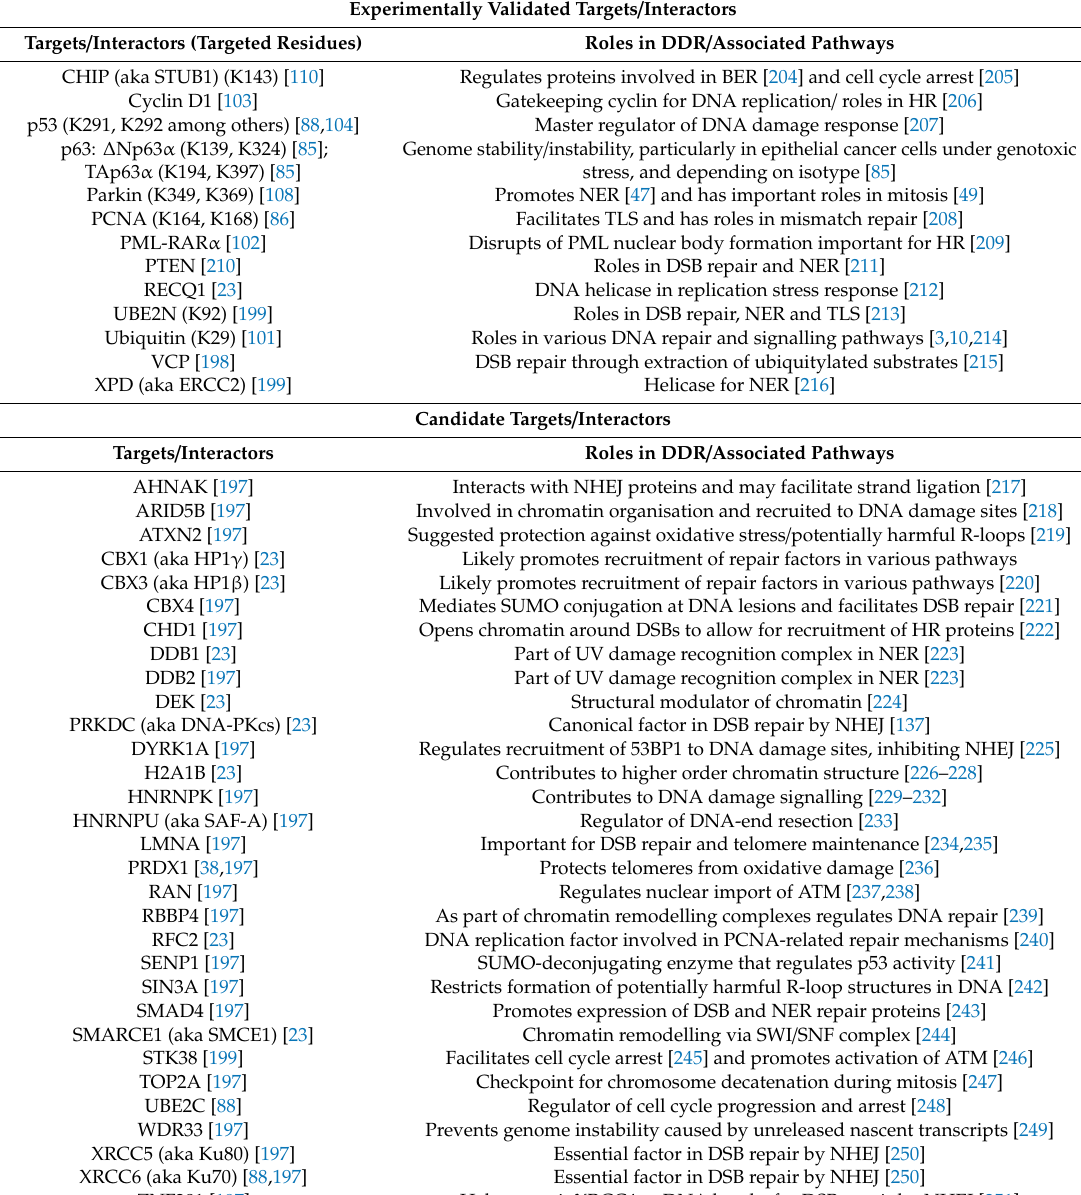
Table 1. Selected validated / candidate ISG15 interactors relevant to DNA damage response and